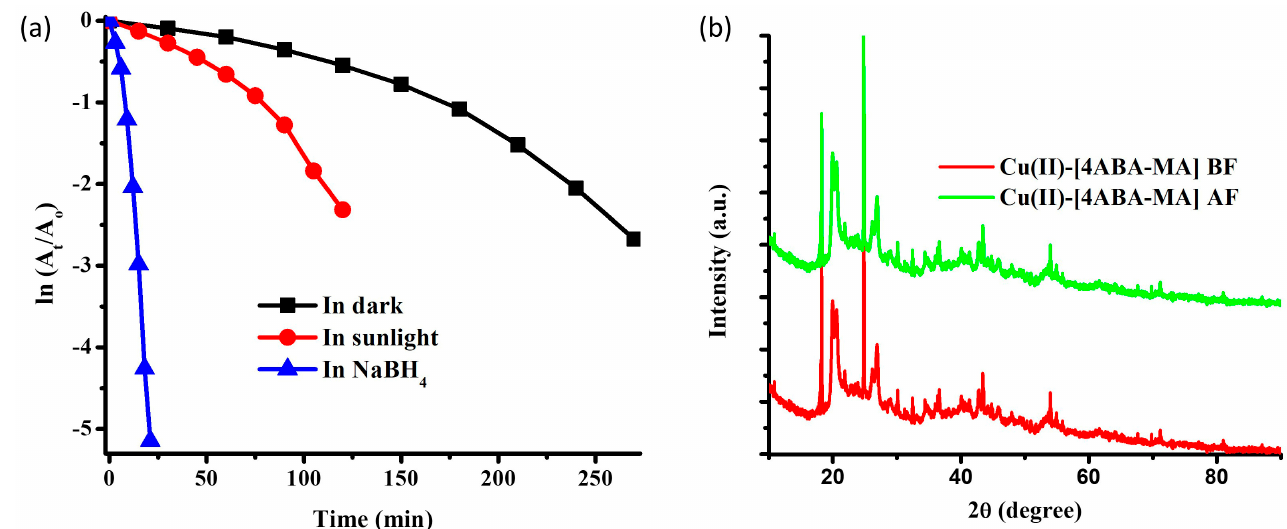
Figure 5. Photocatalytic performance of Cu(II)–[ABA–MA] MOF ( a ) Degradation kinetics under different conditions (the black line represents the absence of both sunlight and NaBH 4 and the red line represents the presence of sunlight but the absence of NaBH 4 , while the blue line represents the presence of NaBH 4 but the absence of sunlight). ( b ) XRD spectra of Cu(II)–[ABA–MA] MOF before (red color) and after (green color) photocatalytic degradation of MeBl. Table 1. Comparison of photocatalytic activity of Cu(II) − [ABA − MA] MOF with other systems.